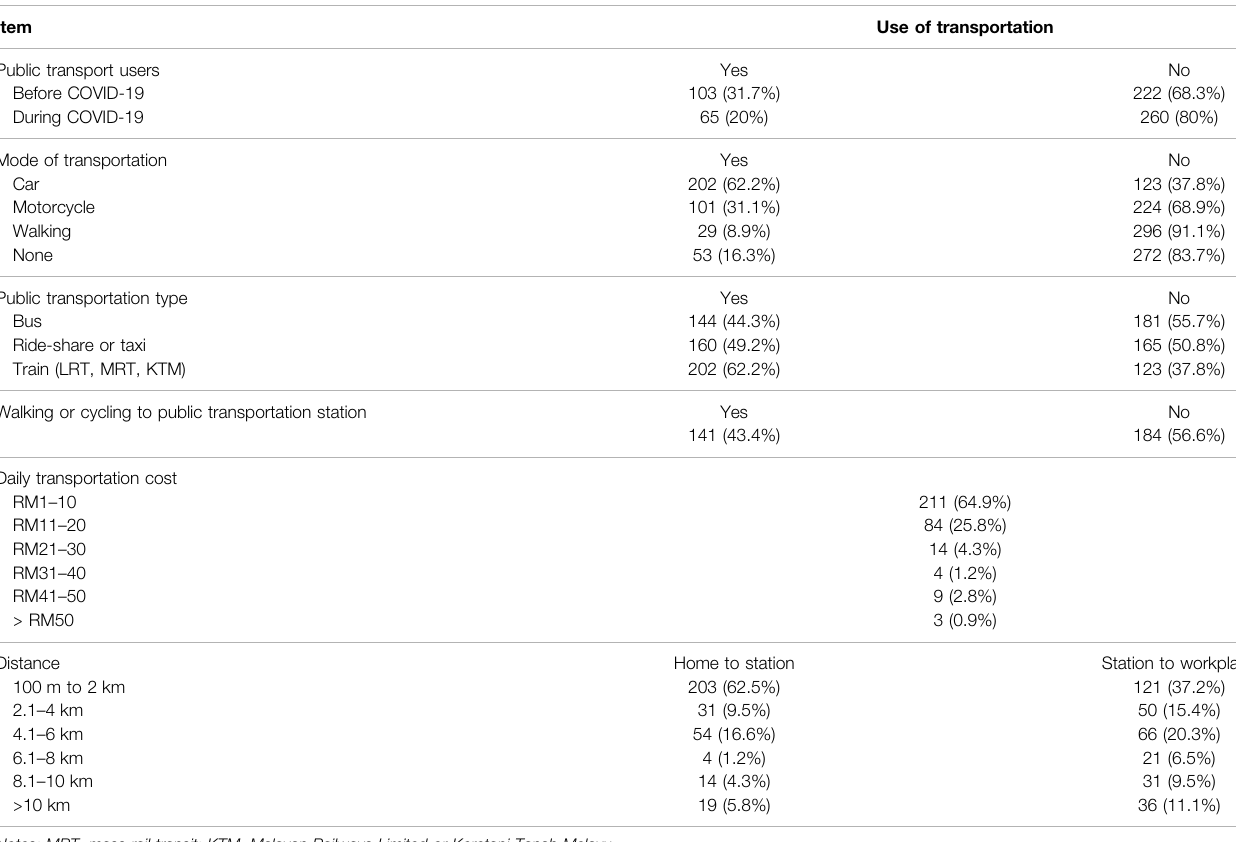
TABLE 3 | Use of the various modes of transportation.